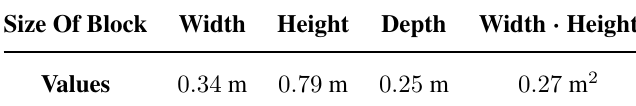
Table 2. The size of a